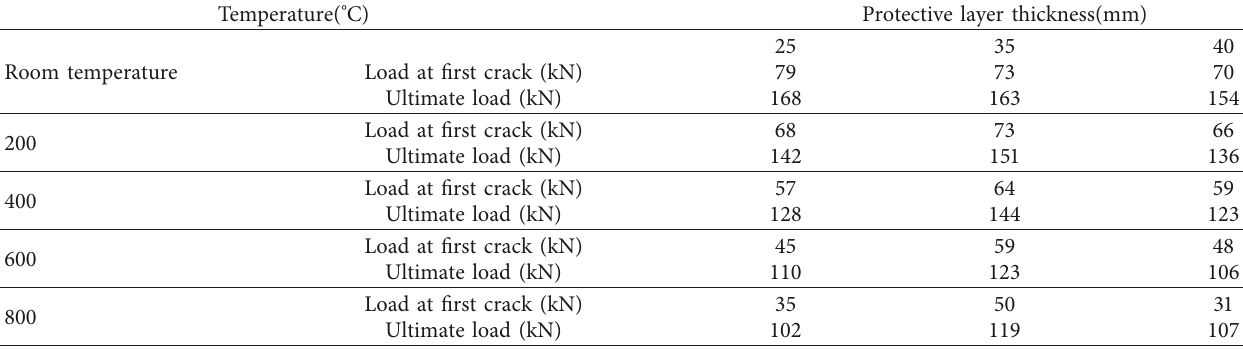
Table 6: Cracking and limit loads for beams with different concrete coverings (150mm × 200mm).